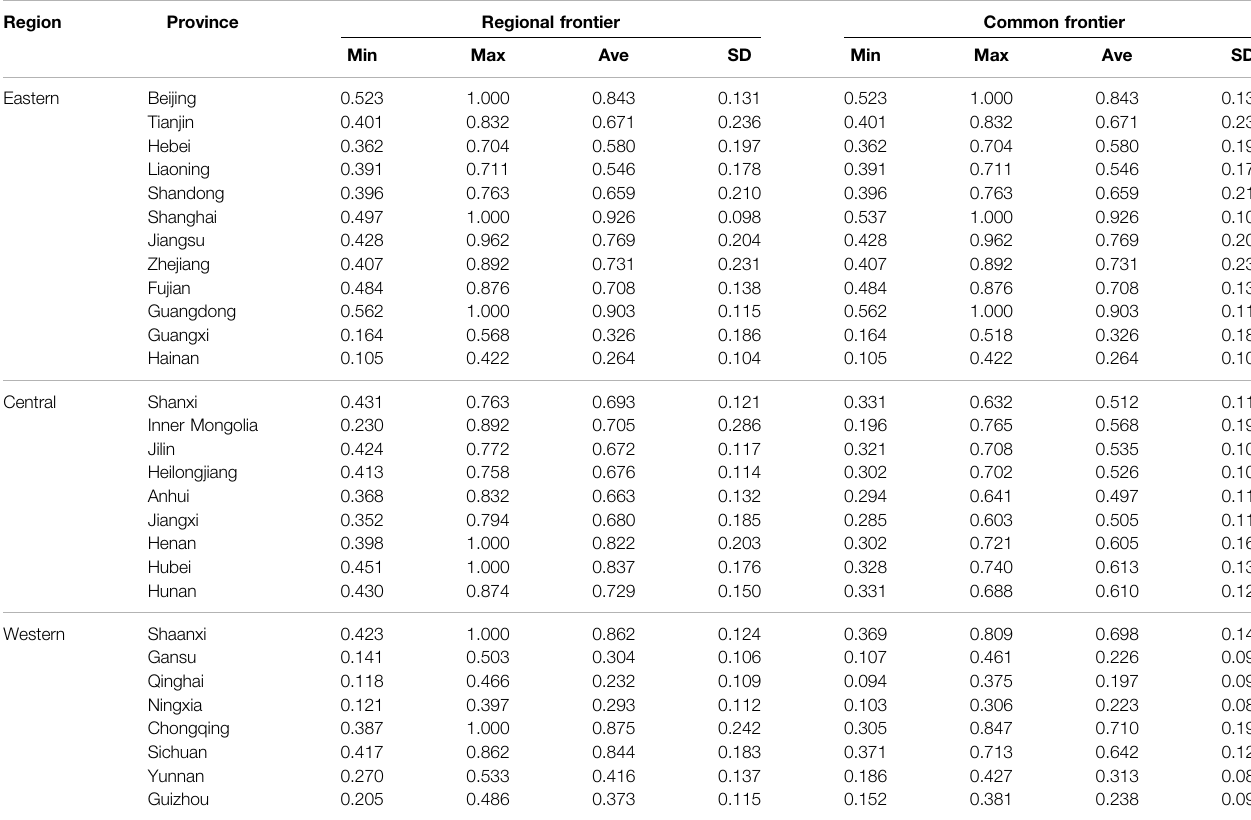
TABLE 2 | Innovation ef fi ciency of the high-tech industry under the regional Frontier and the common Frontier in 1999 – 2018. Region Province Regional frontier Common frontier Min